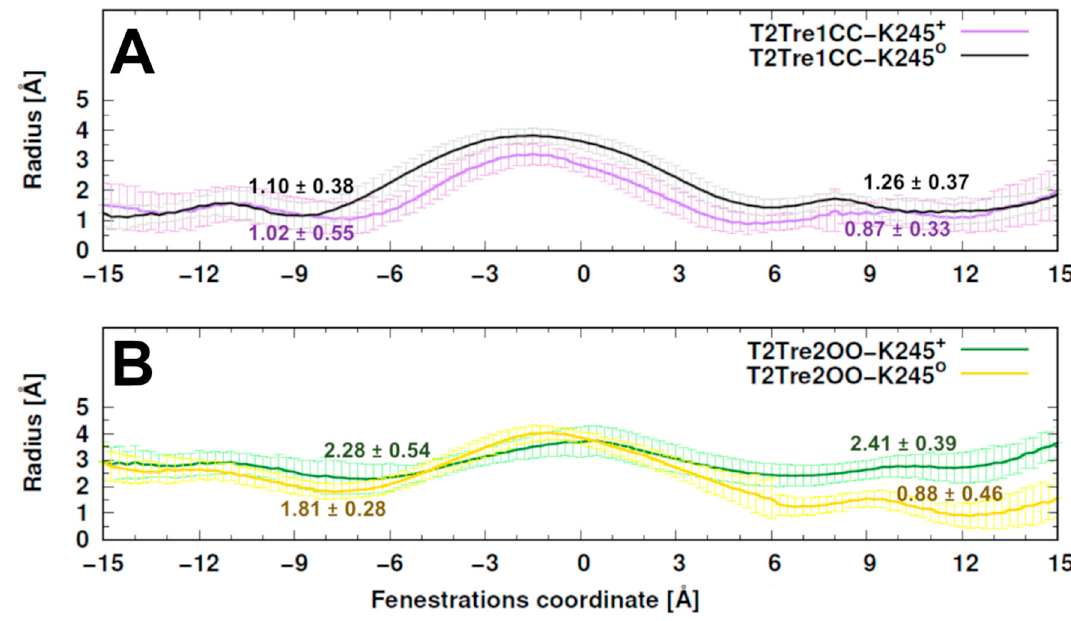
Figure 3. Comparing the dimensions of the fenestrations during TASK-2 MD simulations. ( A ) represents the average ± standard deviation of both fenestrations size for TASK-2 simulations (T2Tre1CC-K245 + in purple and T2Tre1CC-K245 0 in black). Similar to ( A ), TASK-2 simulations at the down-state of the fenestrations are shown in ( B ) for T2Tre2OO-K245 + in green and T2Tre2OO-K245 0 in yellow. The calculations were performed with the HOLE program for three replicas per system. The fenestrations are disposed in the X -axis [ − 15, − 6] Å and [6, 15] Å, while the central cavity is located at [ − 5, 5] Å approximately. The numbers over each plot represent the bottleneck radius in each fenestration.